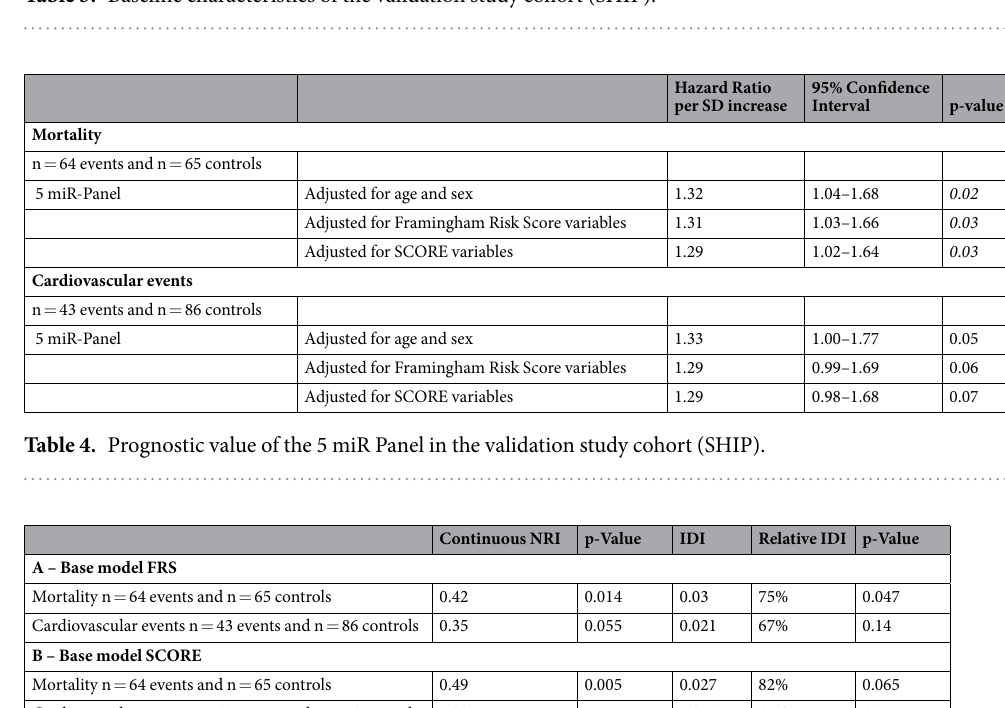
Table 3. Baseline characteristics of the validation study cohort (SHIP).